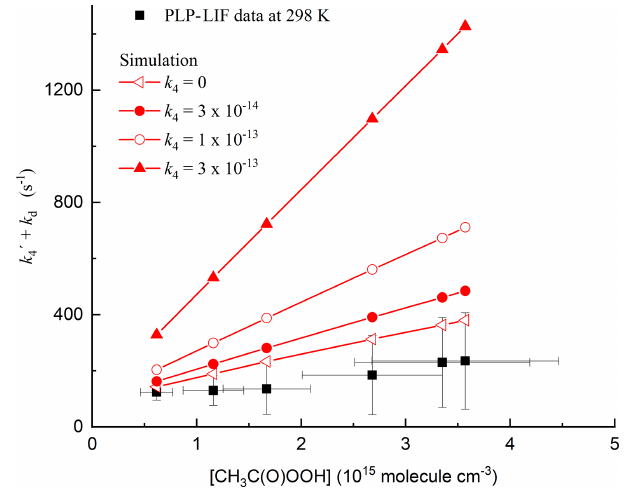
Figure 7. Results of 24 simulations (in red) of the chemistry initiated by the photolysis of CH 3 C(O)OOH in the presence of CH 3 C(O)OH including reactions of OH with CH 3 and CH 3 C(O)O 2 radicals. As in the experimental data (only those obtained at 298K are plotted), the contribution of CH 3 C(O)OH to the OH decay con- stant has been subtracted from each data point. In addition, a diffu- sion term of 100s − 1 has been added to the simulations so that the same intercept (at zero CH 3 C(O)OOH) is